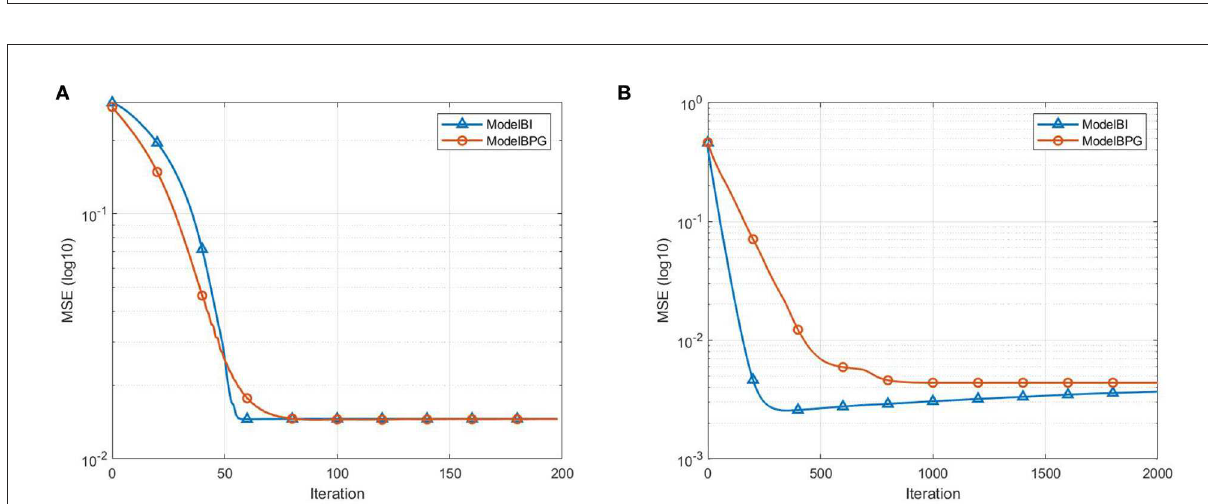
FIGURE3 Convergence behavior in the case of noisy data with σ 2 0.004: (A) MSE vs. number of iterations, presents the convergence behavior of ModelBI = and Model BPG for Model A; (B) MSE vs. number of iterations, presents the convergence behavior of ModelBI and Model BPG for Model